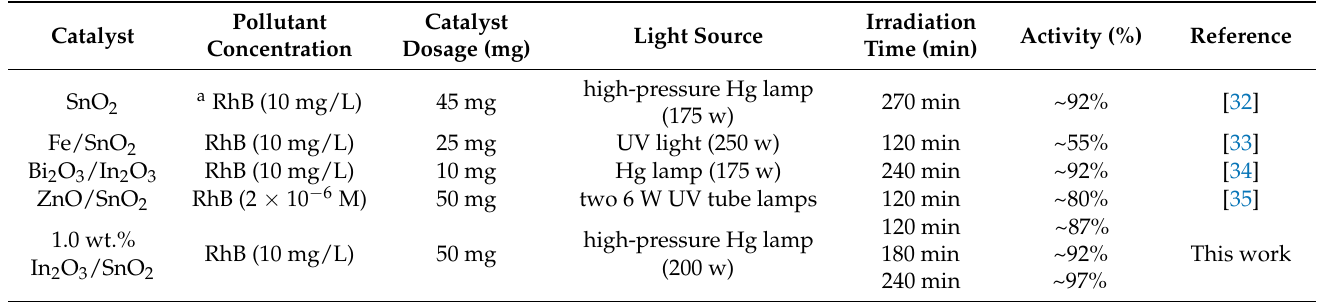
Table 2. Comparison of photocatalytic efficiencies of various SnO 2 -based photocatalysts for degrada- tion of organic